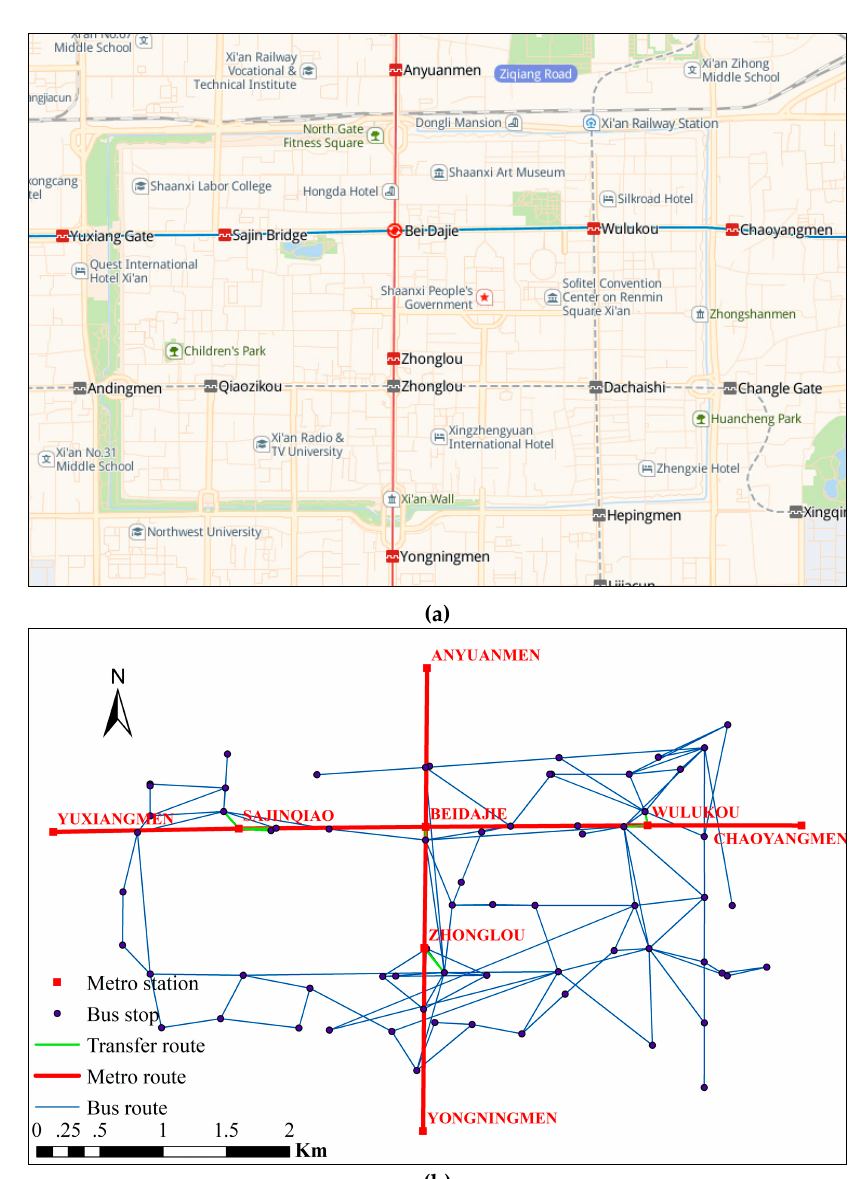
Figure 5. Bus–Metro CBN of the area encircled by Xi’an City wall. ( a ) Actual Bus–Metro CBN traffic network. ( b ) Corresponding Bus–Metro CBN topological network .